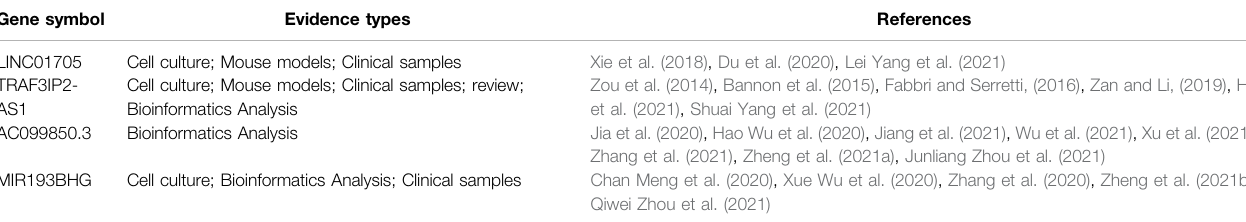
TABLE 3 | Summary statistics of available studies on FRLs.